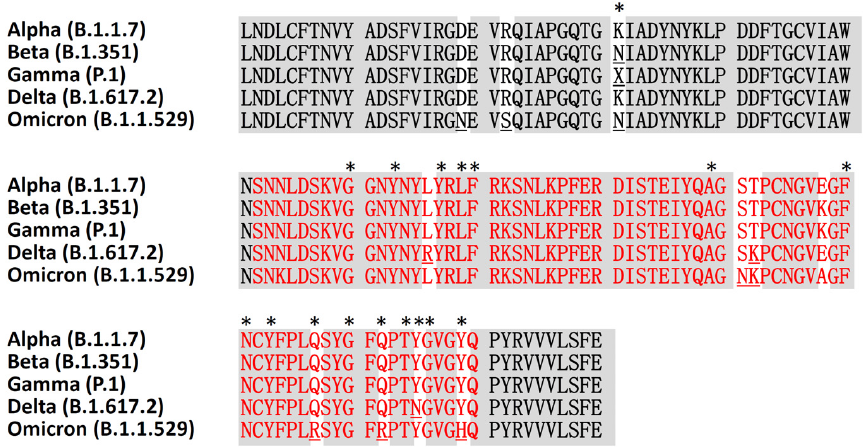
Figure 3. Multiple sequence alignment of the receptor-binding domains amino acid sequences of five SARS-CoV-2 variants. Contacting residues in the SARS-CoV-2 receptor-binding